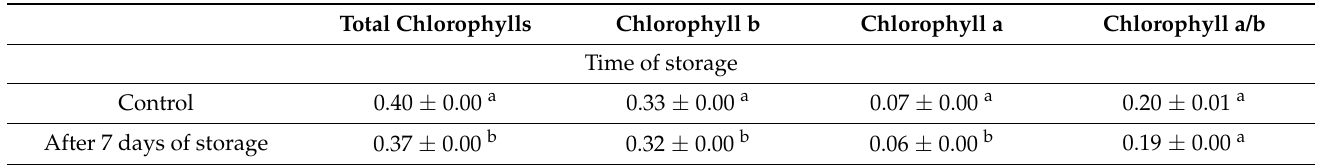
Table 3. The content of total chlorophylls and individually identified chlorophyll forms in apple (in mg/100 g